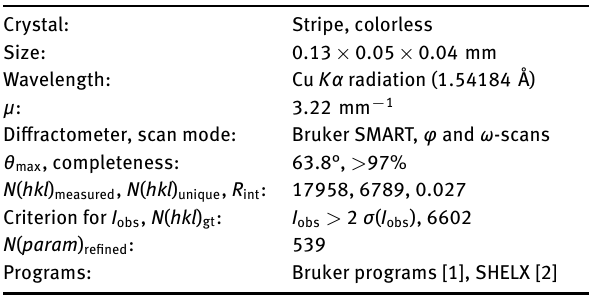
Table 1: Data collection and